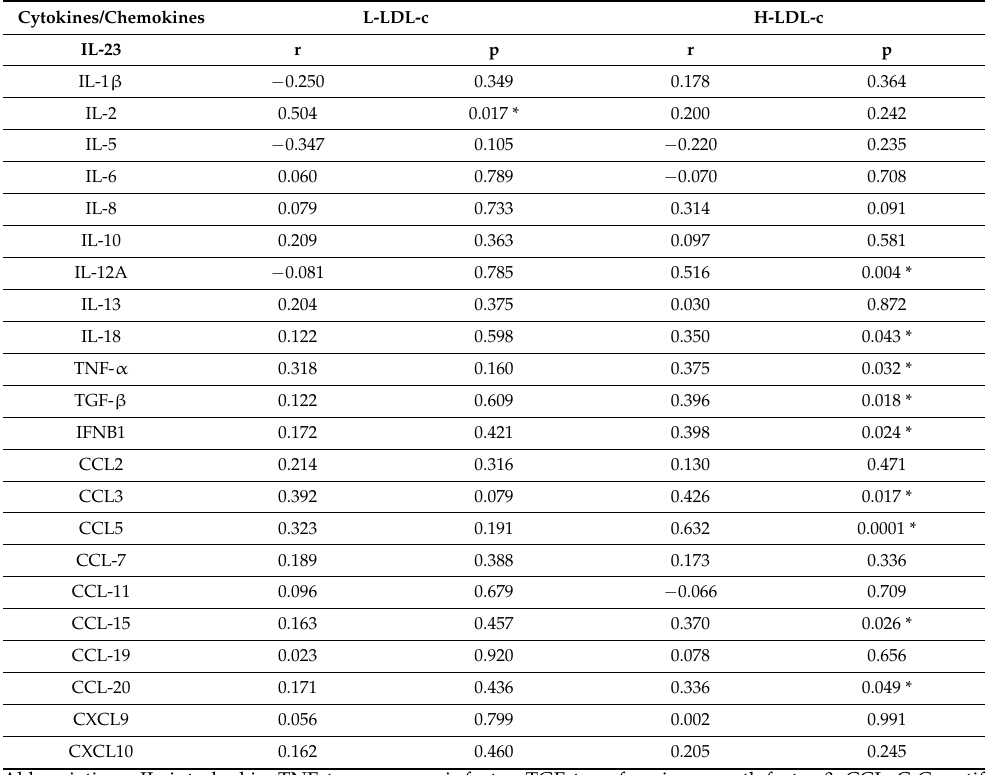
Table 5. Association of IL-23 with cytokines/chemokines in the people with H-LDL-c. Cytokines/Chemokines L-LDL-c